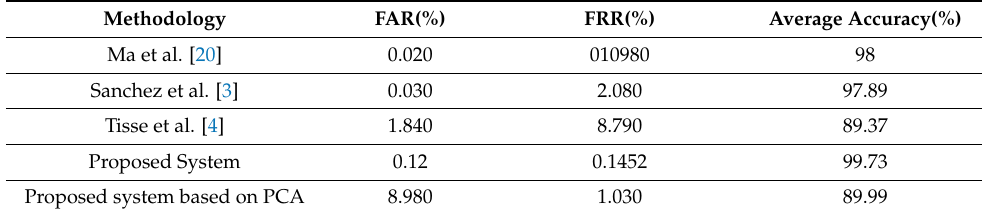
Table 1. Performance comparison of different